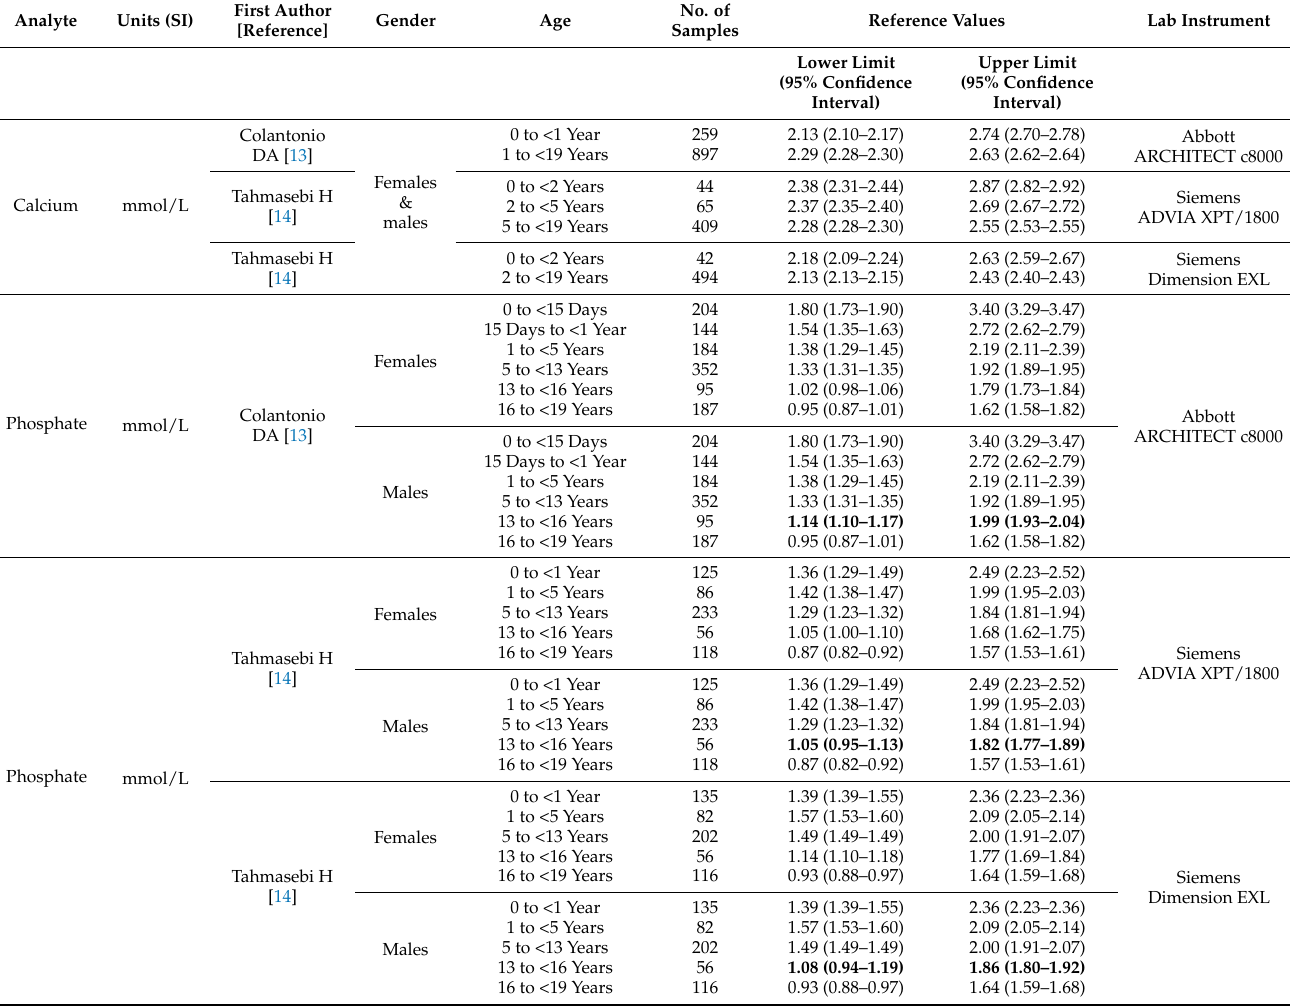
Table 1. Age-specific and sex-specific pediatric reference intervals for calcium, phosphate, 1,25- dihydroxyvitamin D (1,25(OH) 2 D), parathyroid hormone (PTH), COOH-terminal (cFGF23) and intact fibroblast growth factor 23 (iFGF23) and Klotho